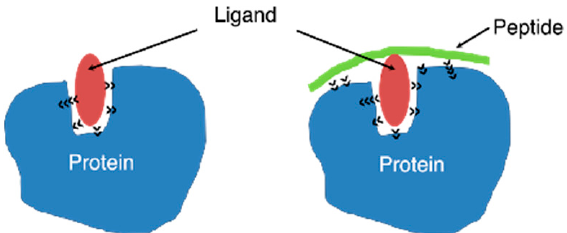
Figure 1. Schematic showing how a peptide conjugated to a ligand (folate) enhances the affinity of the ligand toward the target protein (folate receptor). The black arrowheads indicate molecular interactions.